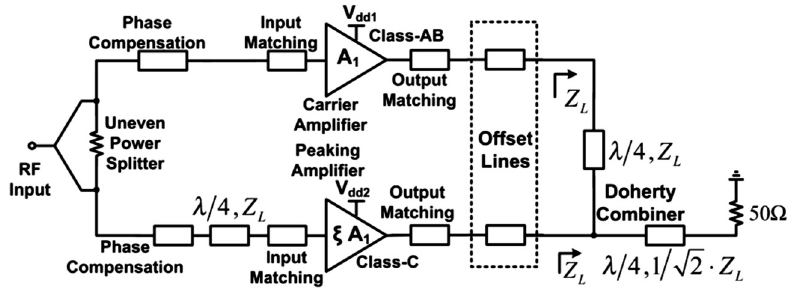
Figure 2. Two-way Doherty power amplifier scheme [19].